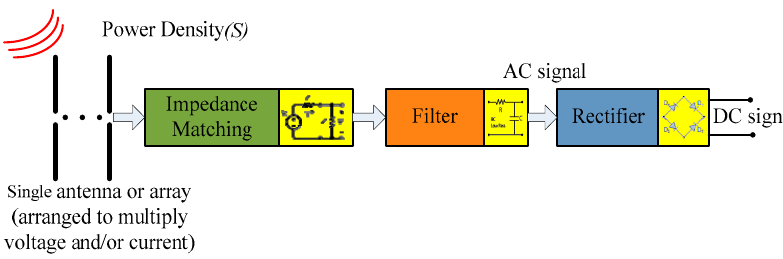
Figure 13. Block diagram of radio frequency energy harvesting system.